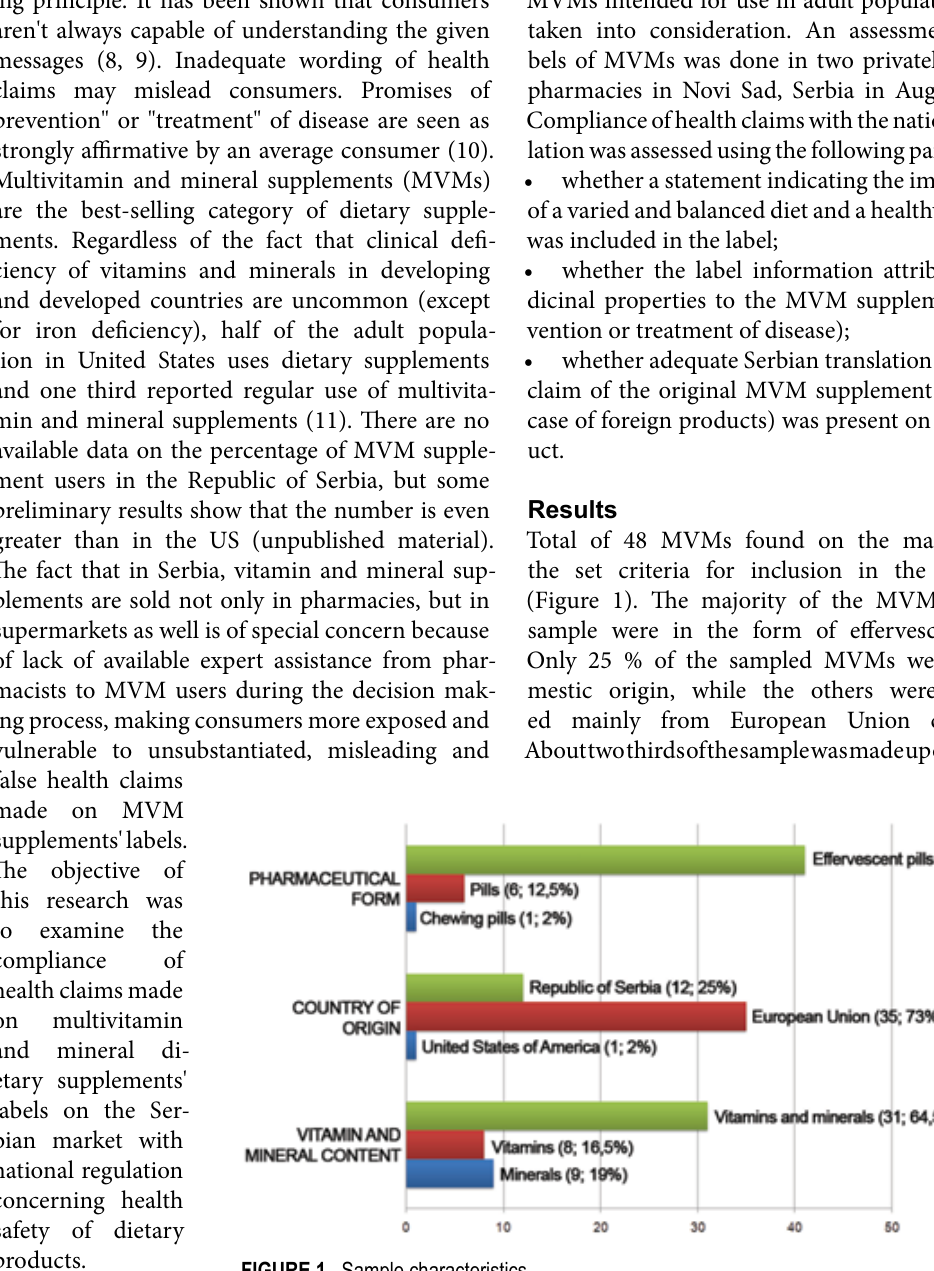
FIGURE 1. Sample